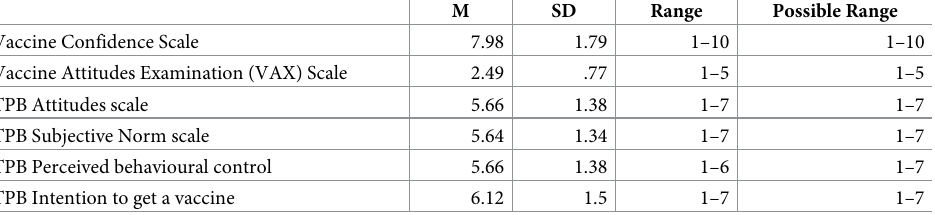
Table 2. Mean score, standard deviation, range and possible range for the Vaccine Confidence Scale, Vaccine Atti- tudes Examination (VAX) scale and theory of planned behaviour subscales (Attitudes, subjective norms, perceived behavioural control and intention to get a vaccine) are presented.